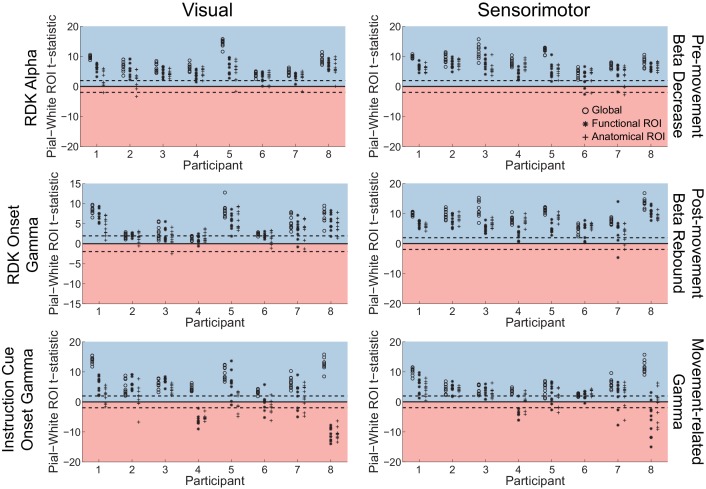
Sensor shuffling biases visual and sensorimotor laminar specificity to the pial surface.Each panel shows the t-statistics comparing the unsigned magnitude of the change in power between the pial and white matter surfaces, averaged within the regions of interests (ROIs), over all participants. T-statistics for the whole brain (circles), functionally defined (asterisks), and anatomically-constrained (crosses) ROIs are shown for 10 random sensor shuffles. Red background indicates a bias towards the white matter surface, and blue background a bias towards the pial surface. The dashed lines indicate single participant-level significance thresholds. Shuffling the sensor locations destroys the true mapping between the neural sources and the sensors, resulting in a bias toward the pial surface in all frequency bands and task epochs in both visual and sensorimotor cortex.